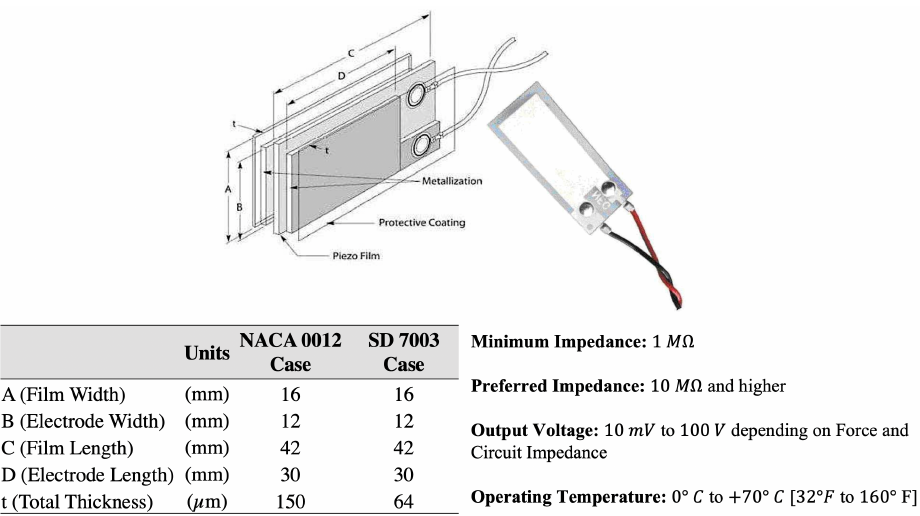
Figure 8. Specifications of the piezo embedded PVDF material used in NACA 0012 and SD7003